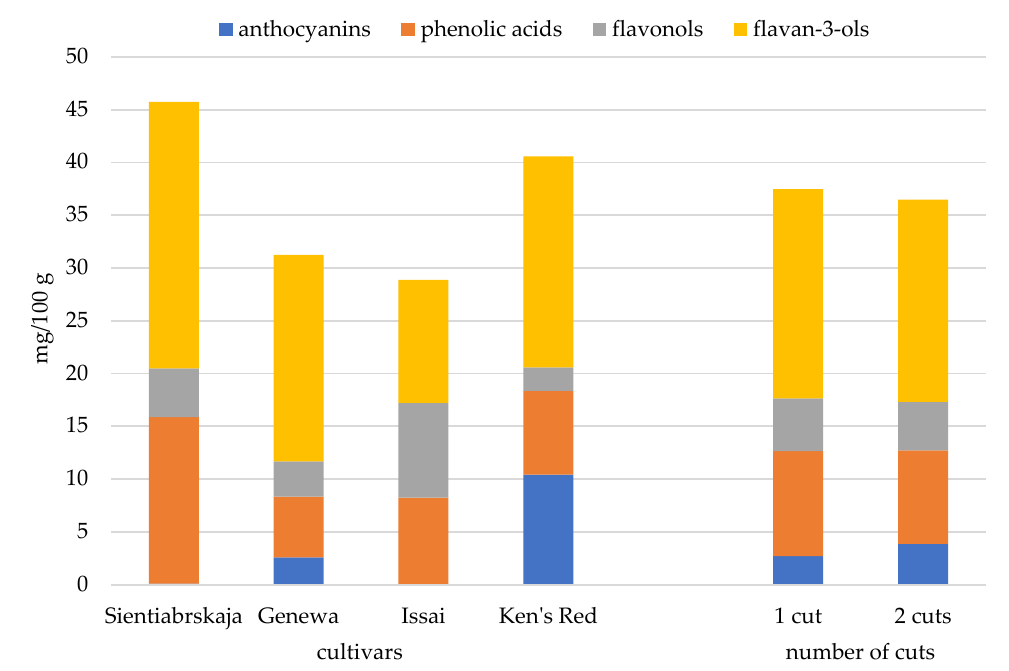
Figure 1. Sum of polyphenols in the studied cultivars of Actinidia. Table 6. Polyphenols derivative contents in Actinidia Nine flavonols were found. The highest contents of five of them were found in ‘Ken’s Red’ fruit. The number of cuts affected the values of five of the studied flavonols. The first cutting increased the content of rutin, kaempferol 3- O -rutinoside and kaempferol 3- O - glucoside. After the second cut, the contents of quercetin 3- O -galactoside and kaempferol 3- O -glucorhamnoside decreased. The largest differences occurred in the content of quer- cetin 3- O -galactoside. The amount of this compound after the first cut in the Issai cultivar was 99% higher than that for the Ken’s Red cultivar after the second cut.